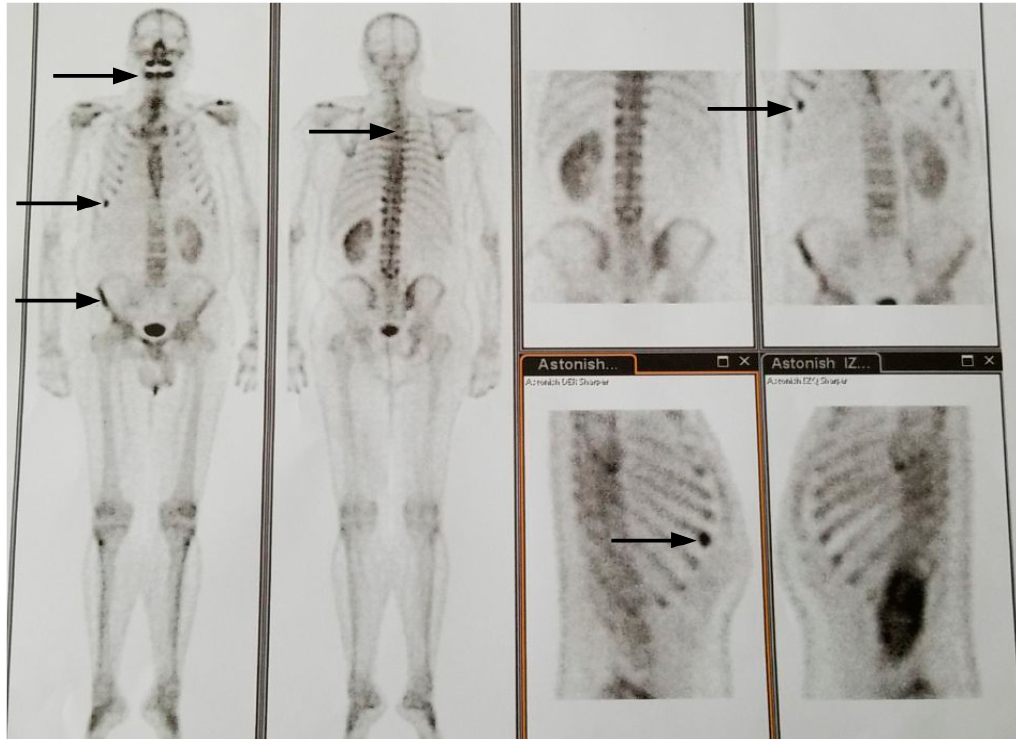
Figure 8. Year 2017: Front view: rib metastasis, iliac bone metastasis, increased radionuclide caption at maxillary alveolar level. Dorsal view: 4–5 dorsal vertebra metastasis. These images were similar to those of 2014. Absence of right kidney due to radical nephrectomy in 2003. Left panel anterior view. Second panel posterior view. Four right panels: upper left: posterior view, upper right: anterior view, lower left: right ribs, lower right: left ribs.